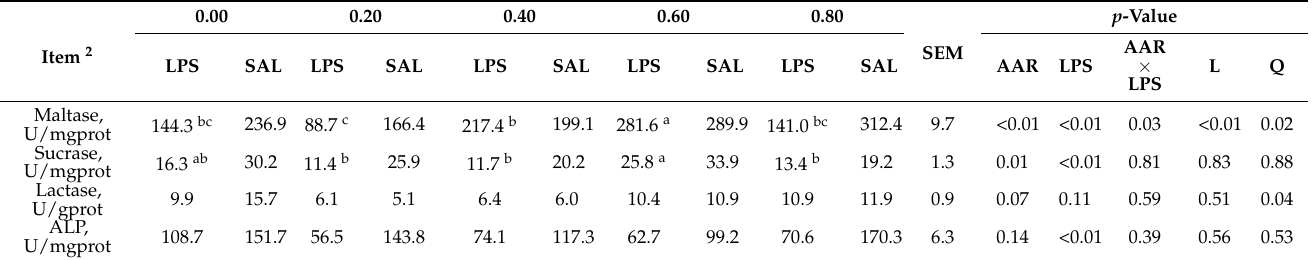
Table 4. Influence of diet with different amylose–amylopectin ratio and LPS challenge (intraperitoneal injection) on the jejunal digestive enzyme activities of weaned piglets 1 .